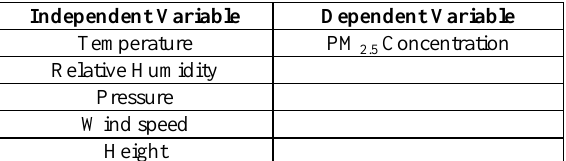
Table 2. Dependent and Independent